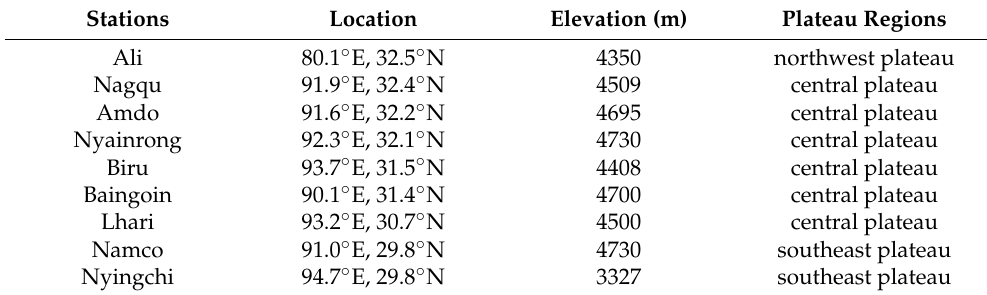
Figure 1. Topography of the Tibetan Plateau, with 9 plateau stations being denoted by red dots. It should be noted that the Nyingchi station was excluded from our study after the data quality control steps were completed. Table 1. Station locations over the plateau